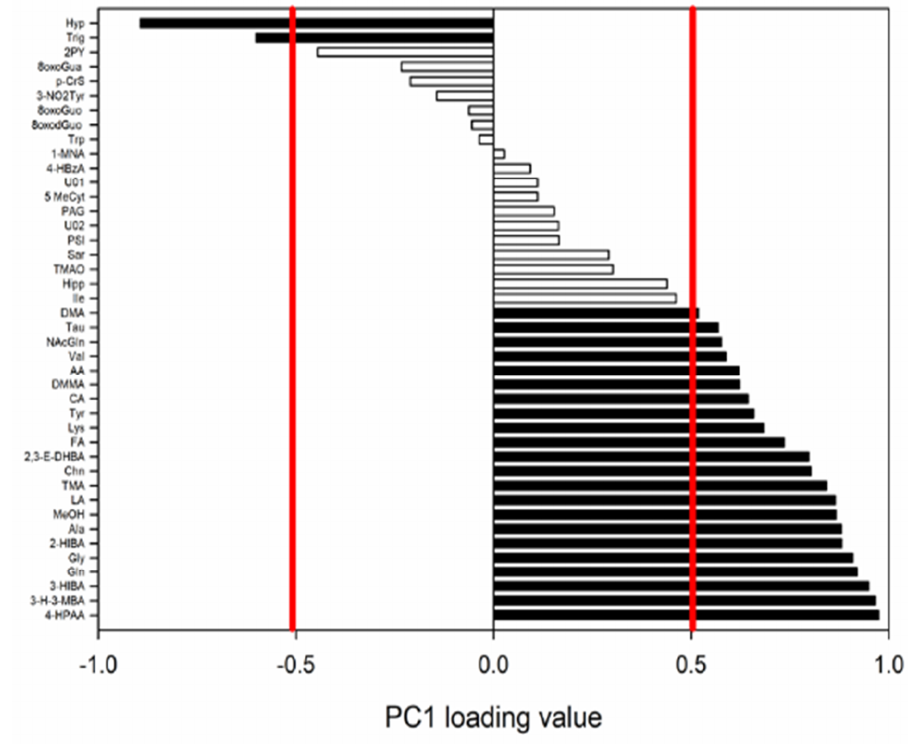
Figure 3. The PCA normalized loading values for PC1. Values greater than 0.514 and lower than −0.514 (red bars) were considered significant for the model ( p < 0.05).